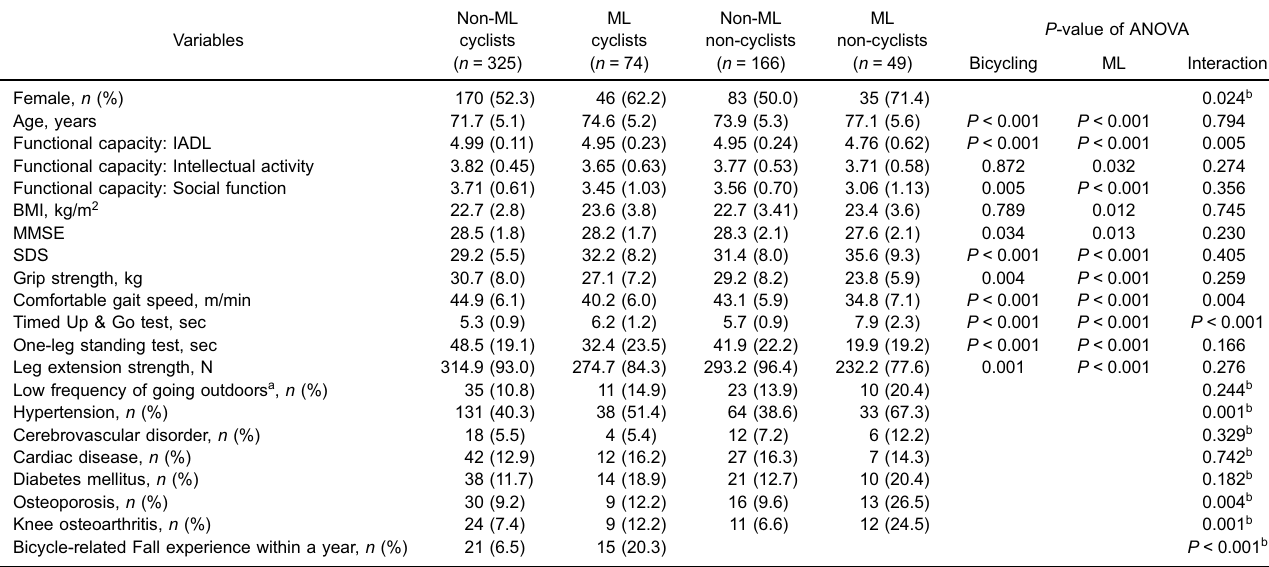
P -value of ANOVA